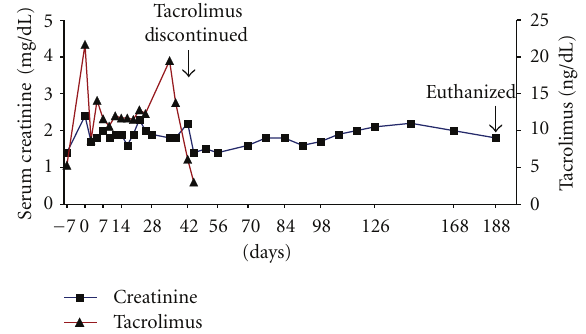
Figure 4: Life-supporting kidney Tx was carried out from a nonir- radiated donor into a recipient immunosuppressed for 42 days with tacrolimus. E ff orts were made to maintain the 12h blood trough level between 10–15 ng/mL. Serum creatinine levels remained between 132.6–176.8 μ mol/L (1.5–2.0 mg/dL) for almost 5 months after discontinuing tacrolimus. The pig was euthanized electively 188 days after kidney Tx.